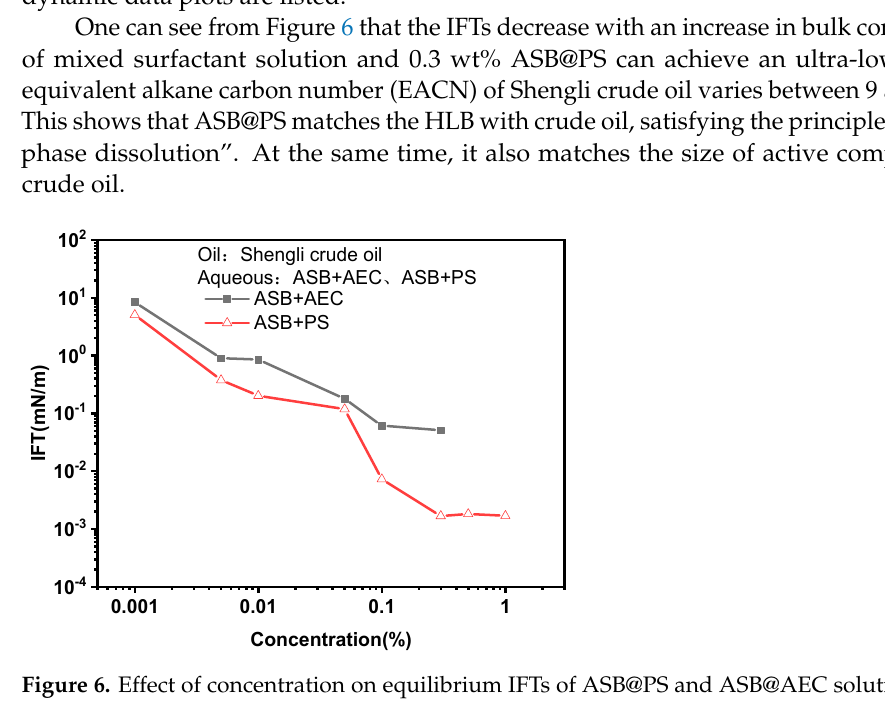
Figure 7. Effect of polymer concentration on equilibrium IFTs between 0.3 wt% ASB@AEC solution and Shengli crude oil. The effect of polymer concentration on equilibrium IFTs between 0.3 wt% ASB@PS solution and Shengli crude oil is plotted in Figure 8. Similar to the n-decane system, the IFT values increase with the addition of the polymers, which are quite different from those of ASB@AEC. This may be due to the fact that the EACN value of crude oil is generally around 10, and the addition of polymers reduces the n min value of ASB@PS, destroying the HLB of the original system and resulting in an increase in the IFT.